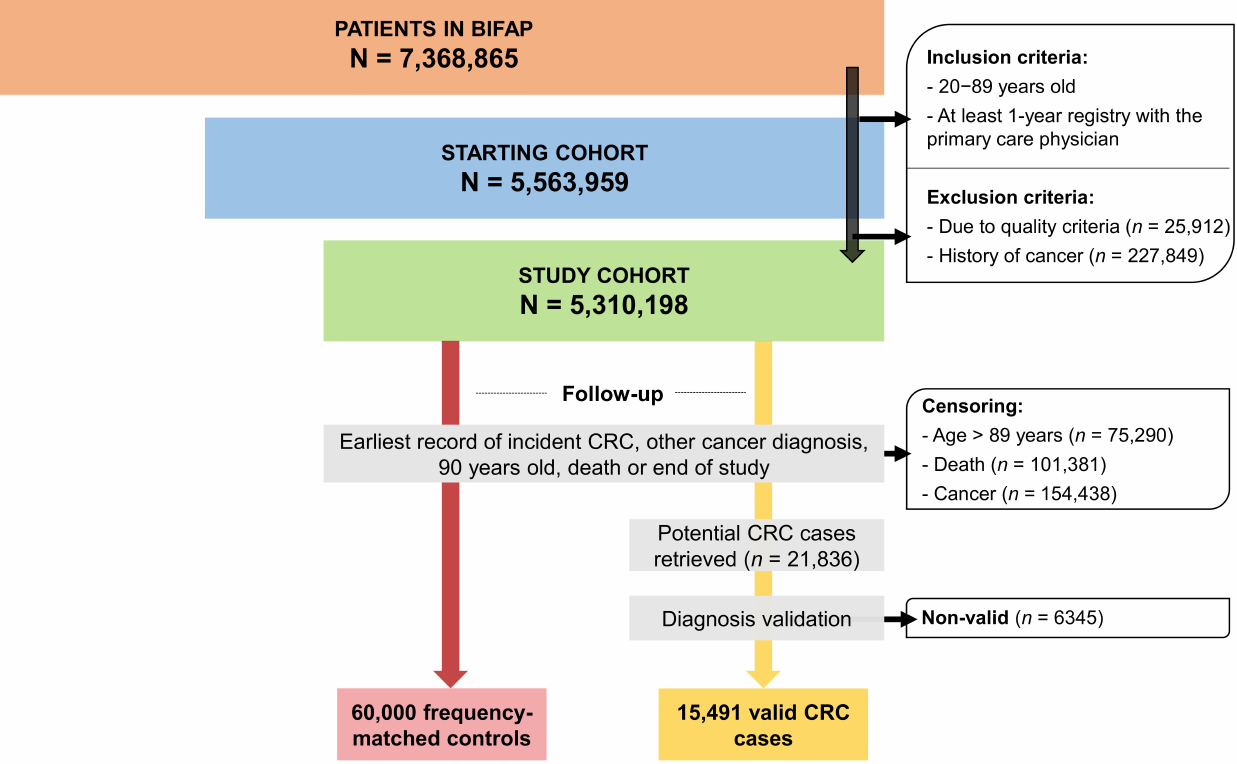
Figure 1. Flowchart of study cohort